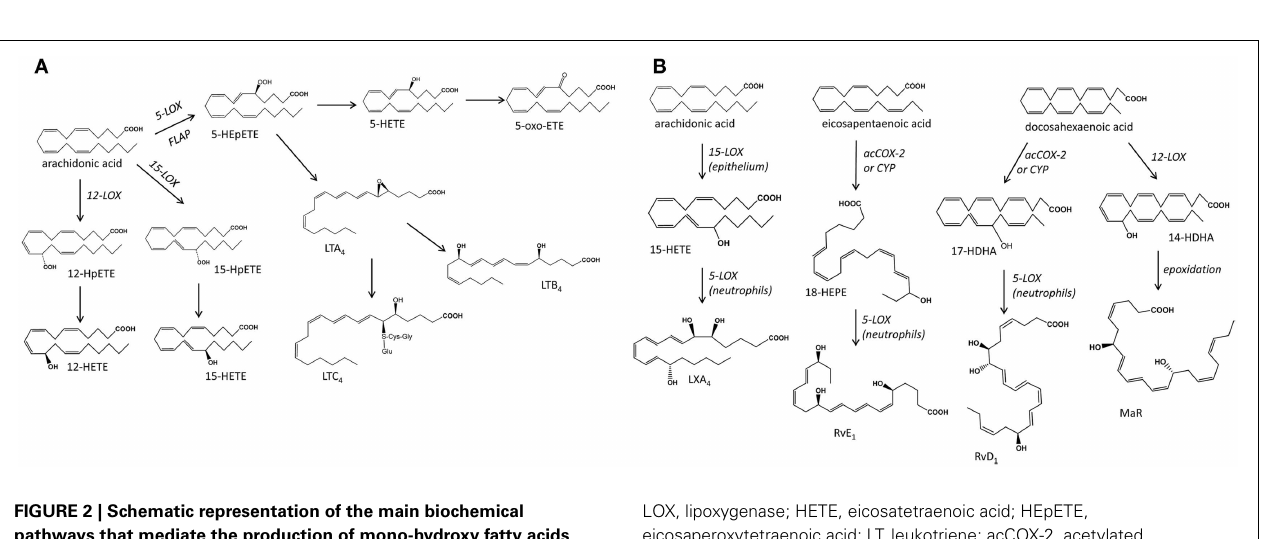
FIGURE 2 | Schematic representation of the main biochemical pathways that mediate the production of mono-hydroxy fatty acids and leukotrienes (A), and the poly-hydroxy fatty acids lipoxins, resolvins, and protectins (B), products of transcellular metabolism .